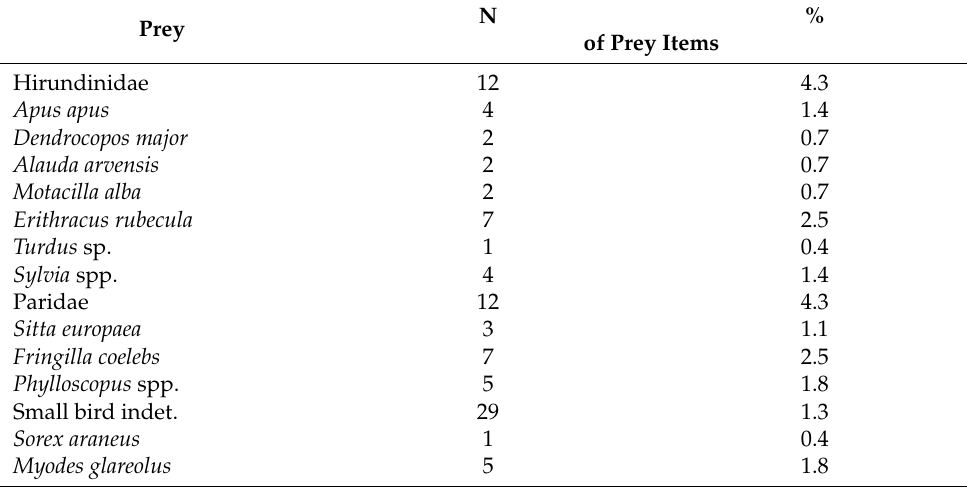
Table A3. The diet composition of hobby ( Falco subbuteo ) in the breeding seasons 2011–2018 in the area of study (central Poland, vicinity of Rog ó w village, Experimental Forest Station of Warsaw University of Life Sciences), based on pellet analysis and prey remains collection. N – number of prey